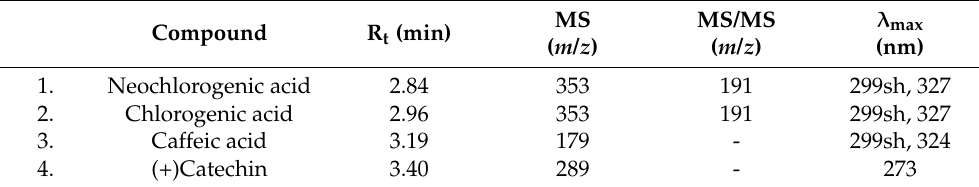
Table 4. Polyphenolic profile identified by